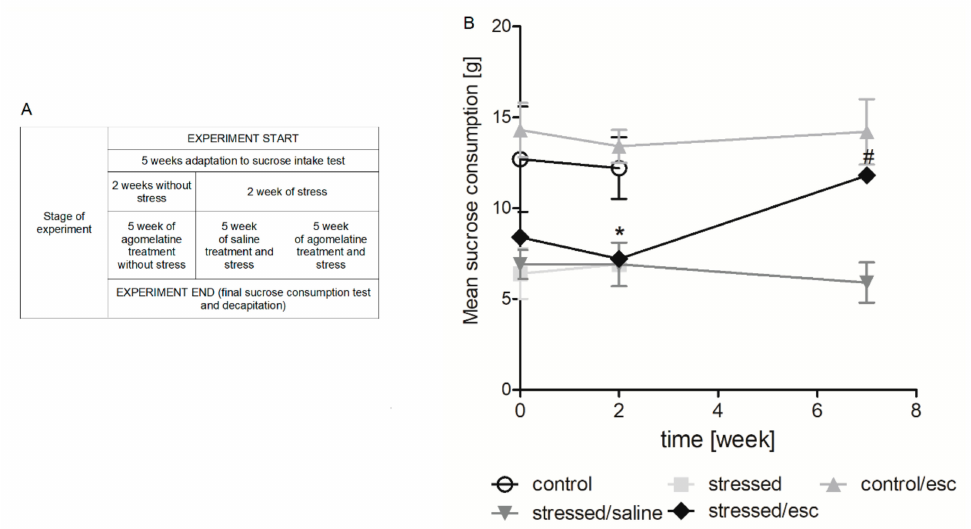
Figure 1. The course of the experiment of chronic mild stress and escitalopram therapy ( A ). Sucrose intake test in rats exposed to CMS for two weeks (week 2) and in animals exposed to CMS for seven weeks (week 7) and administered vehicle (1 mL/kg) or escitalopram (10 mg/kg) for five weeks ( B ). The consumption of 1.0% sucrose solution was measured in a 1-h test by weighing pre-weighed bottles. The data represents means ± SEM. n = 6. * p < 0.01 control group relative to the stressed group; # p < 0.05 stressed group relative to the stressed/esc